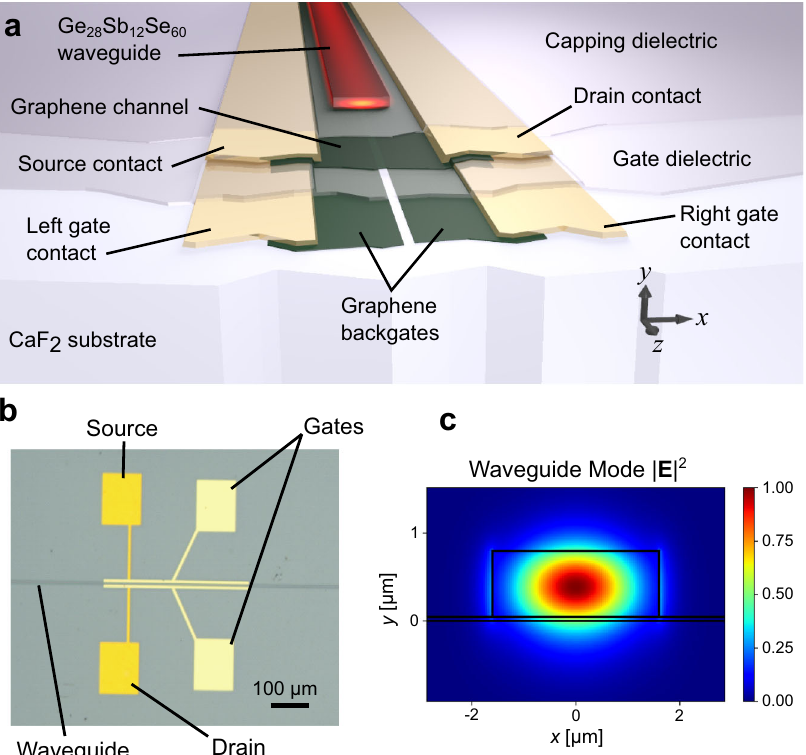
Fig. 1 Device geometry. a Illustration of the device cross-section perpendicular to the waveguide axis. The optical mode supported by the GSSe waveguide evanscently couples to and is absorbed by the graphene channel, which is gated by two graphene back-gates to induce a pn-junction. b Optical image of the device depicting source, drain and gate contact pads. c Depiction of the optical guided mode at λ = 5.2 μ m.